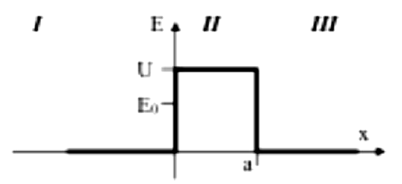
FIG. 11. Typical tunneling problem. A beam of particles with energy E 0 is incident on a square barrier of energy U . Regions I, II, and III are labels.